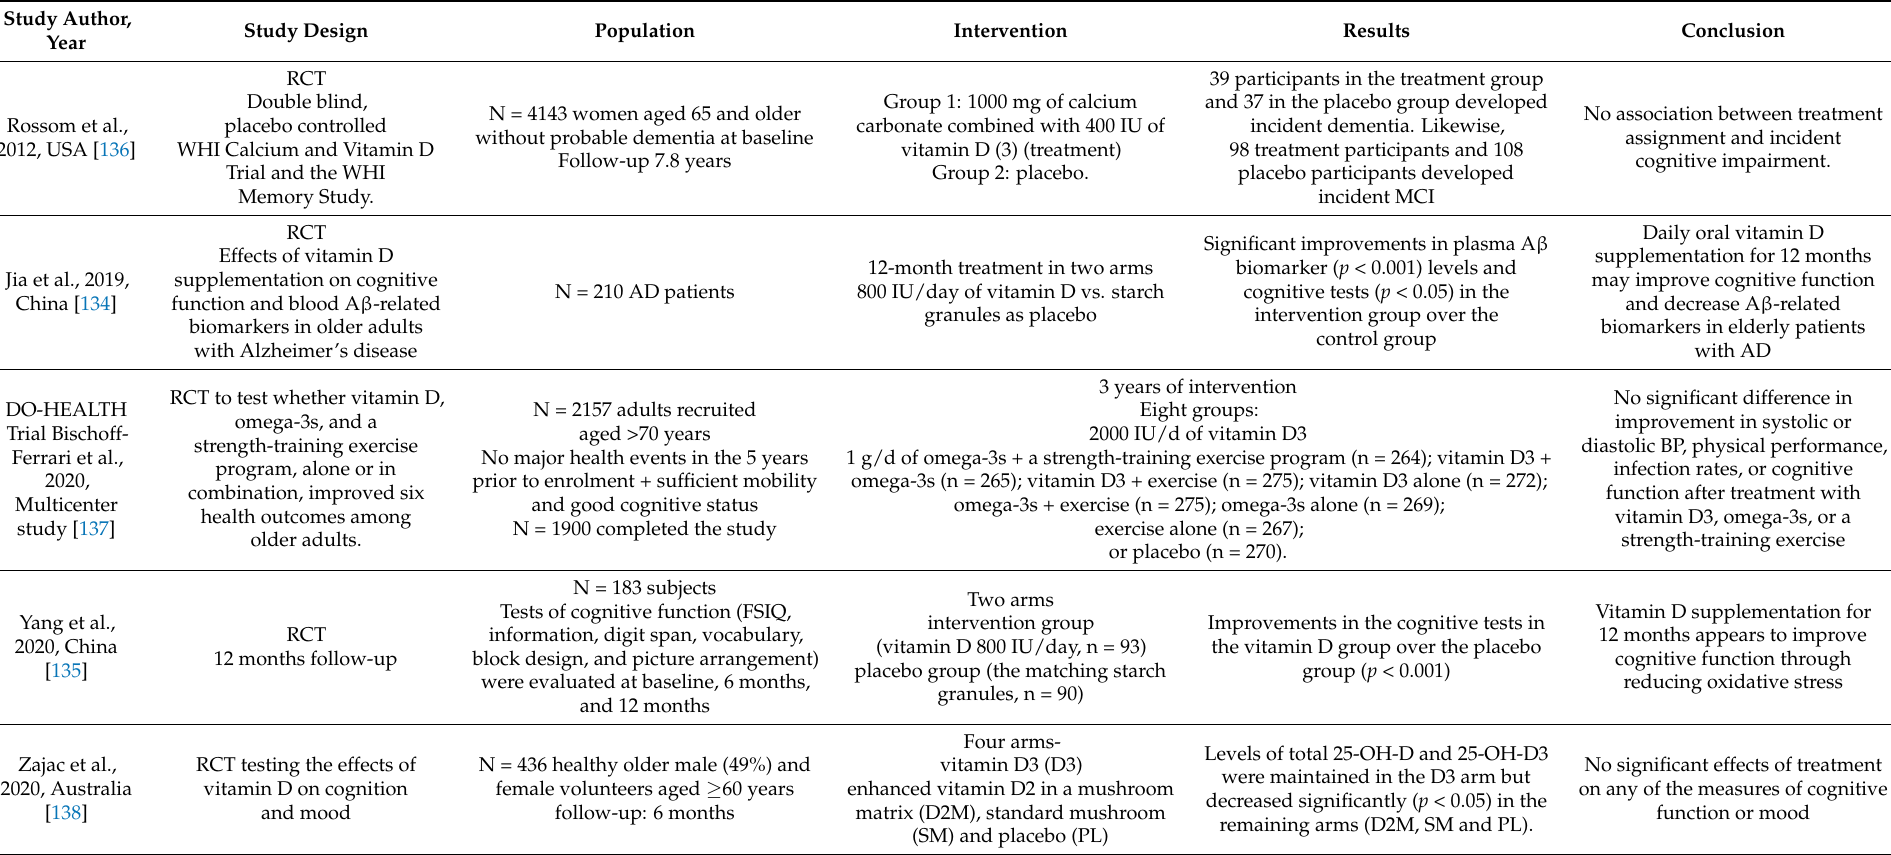
Table 3. Interventional studies on association between vitamin D replacement and cognitive